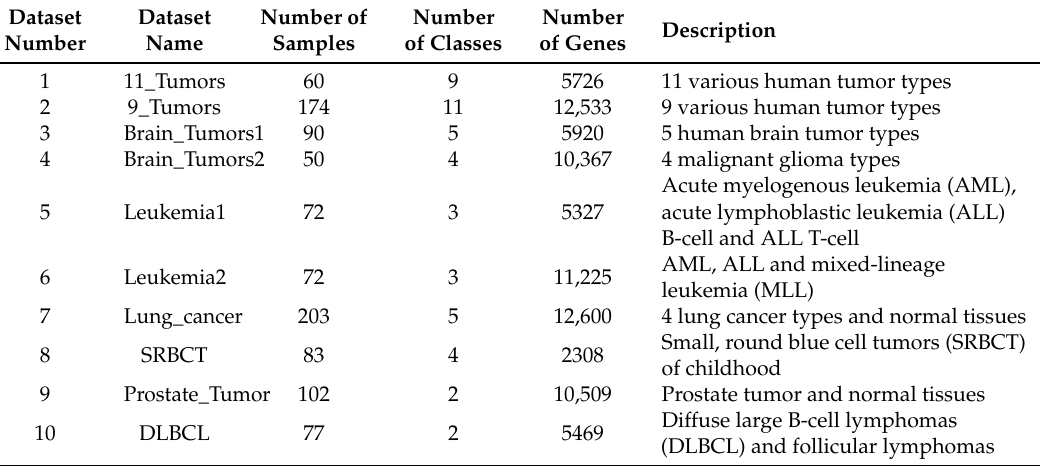
Table 2. Format of gene expression classification